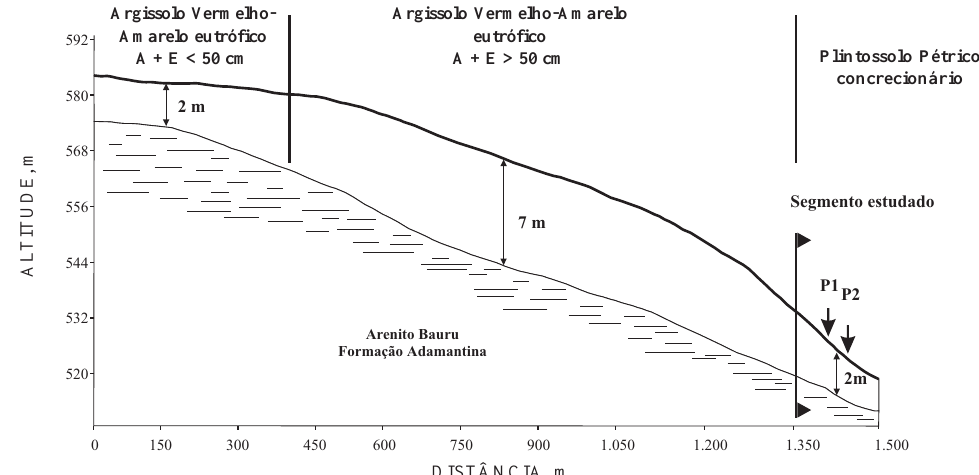
Figura 1. Distribuição dos solos na paisagem e localização do segmento de vertente e dos perfis